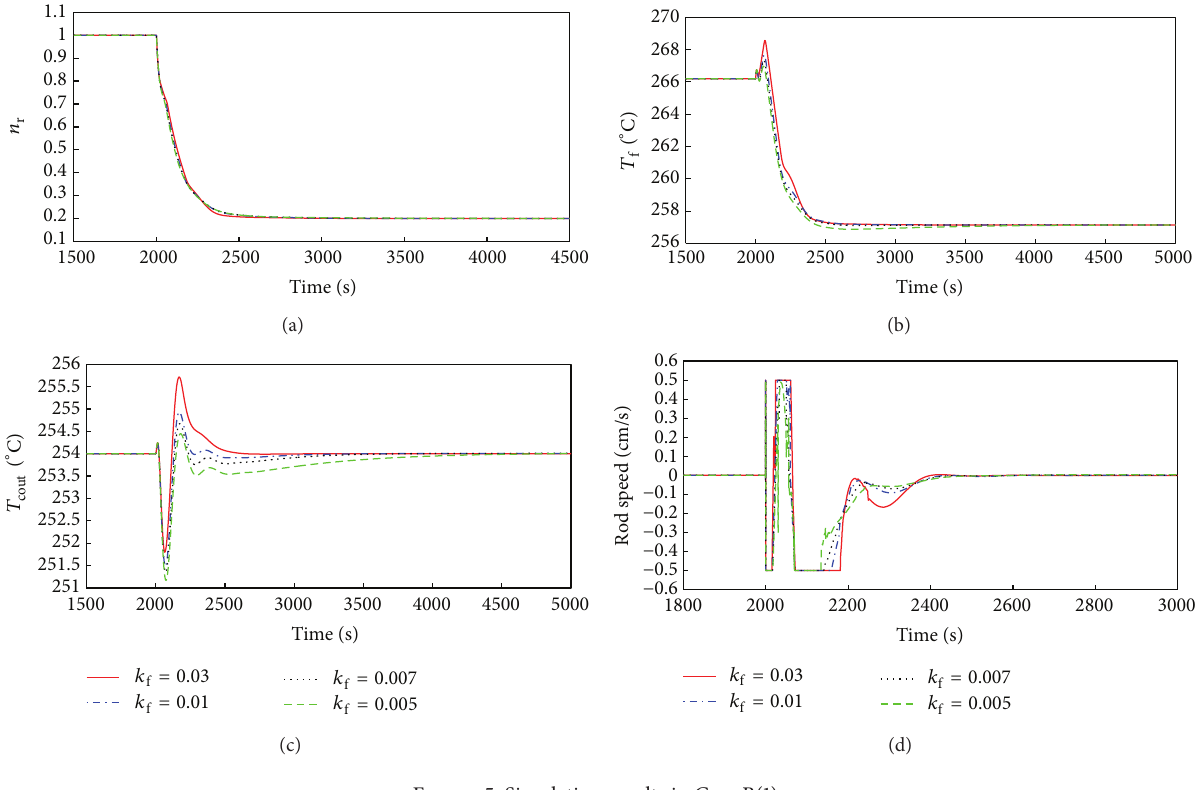
Figure 5: Simulation results in Case